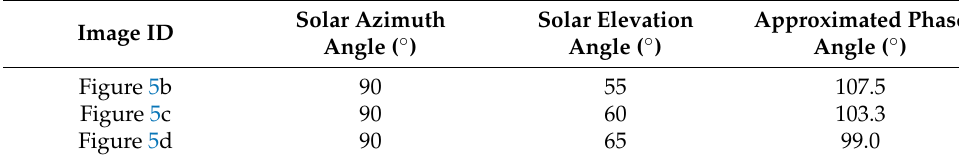
Figure 5. Simulated images under different lighting conditions ( a ) simulate image of solar azimuth angle 90 ◦ and elevation angle 55 ◦ ( b ) simulate image of solar azimuth angle 90 ◦ and elevation angle 60 ◦ ( c ) simulate image of solar azimuth angle 90 ◦ and elevation angle 65 ◦ ( d ). Table 1. Illumination conditions of the simulated